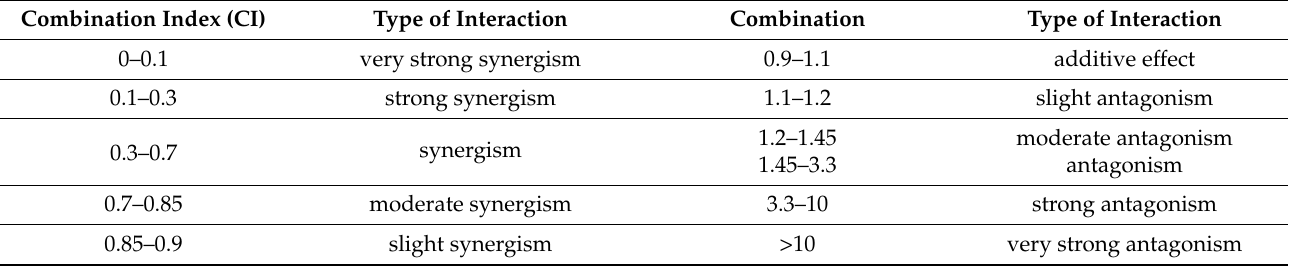
Table 1. Type of interactions based on the combination